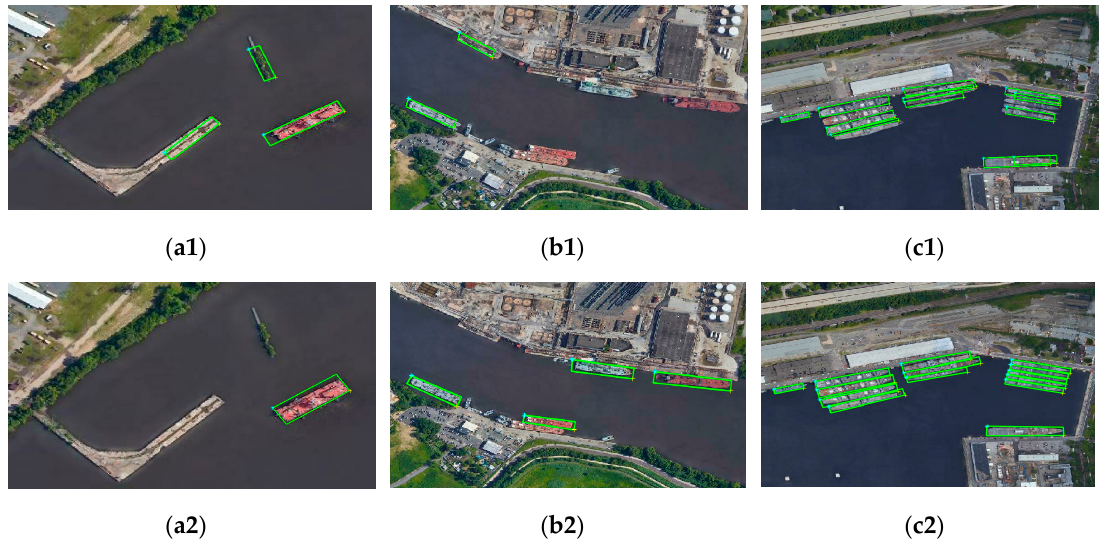
Figure 8. Ship detection results in typical scenes. ( a1 ), ( b1 ) and ( c1 ) of DSOD, ( a2 ), ( b2 ) and ( c2 ) of VA- DSOD.